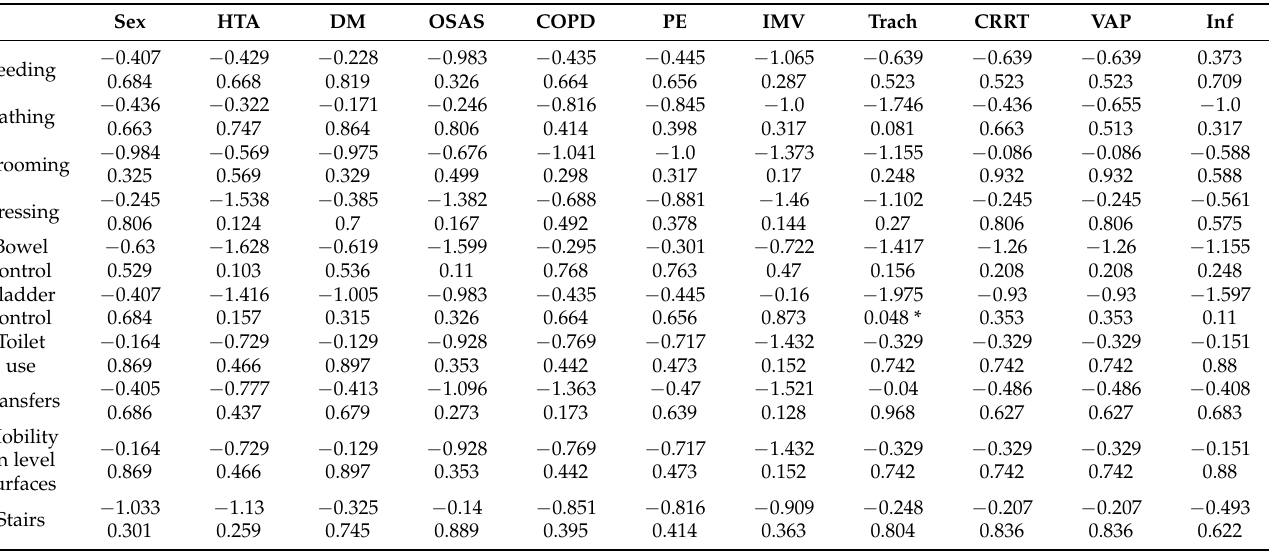
Figure 4. Analysis of boxplot of Barthel index. Boxplot stratification of Barthel index at hospital discharge comparing patients with OSAS, invasive MV and the presence of other infections. OSAS = obstructive sleep apnea syndrome and MV = mechanical ventilation. Further, no correlations between any single acute ADL element of the BI and clinical, biological or intra-ICU data were found (Table 4). Table 4. Correlation analysis of acute activities of daily living (ADLs).